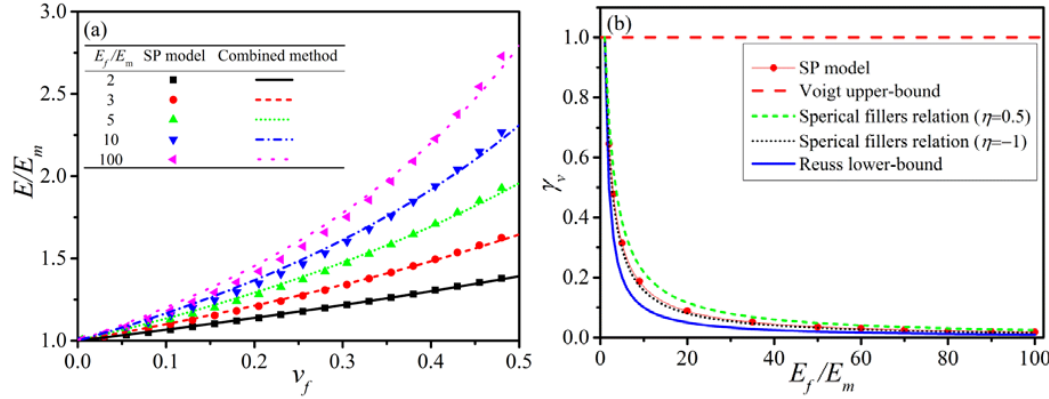
in special cases. Figure 2. ( a ) Comparison between SP model (FEA) and Equation (8); ( b ) The meaning of γ v in 𝛾𝛾 𝑣𝑣